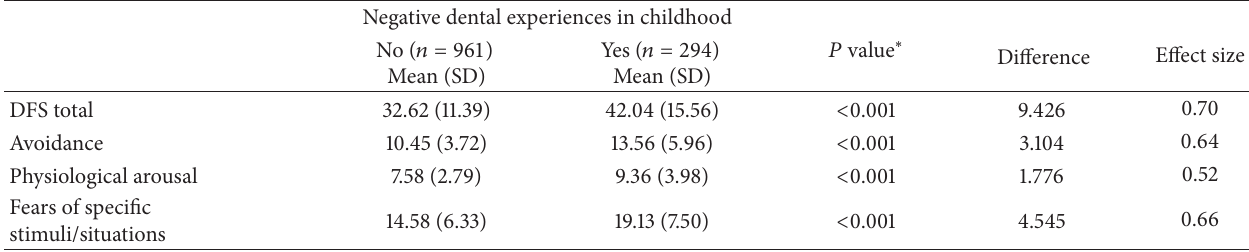
Table 4: Discriminant validity of the Brazilian version of the Dental Fear Survey (DFS) total scale and factors according to negative dental experiences in childhood ( 𝑛 = 1, 255